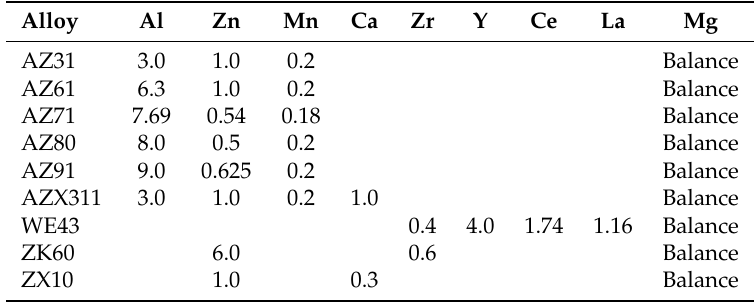
Table A1. Alloy compositions in wt.% used for CALPHAD calculations in this work.